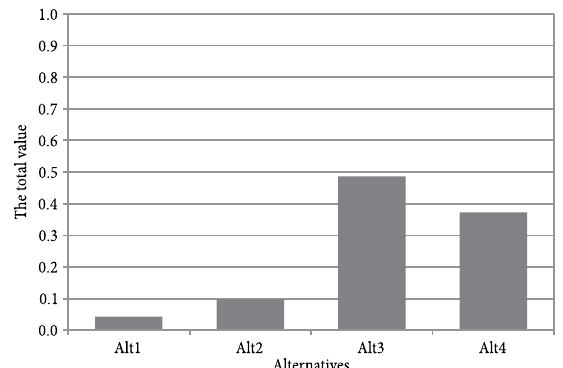
Fig. 7. Resulting graph of the sustainability advocate